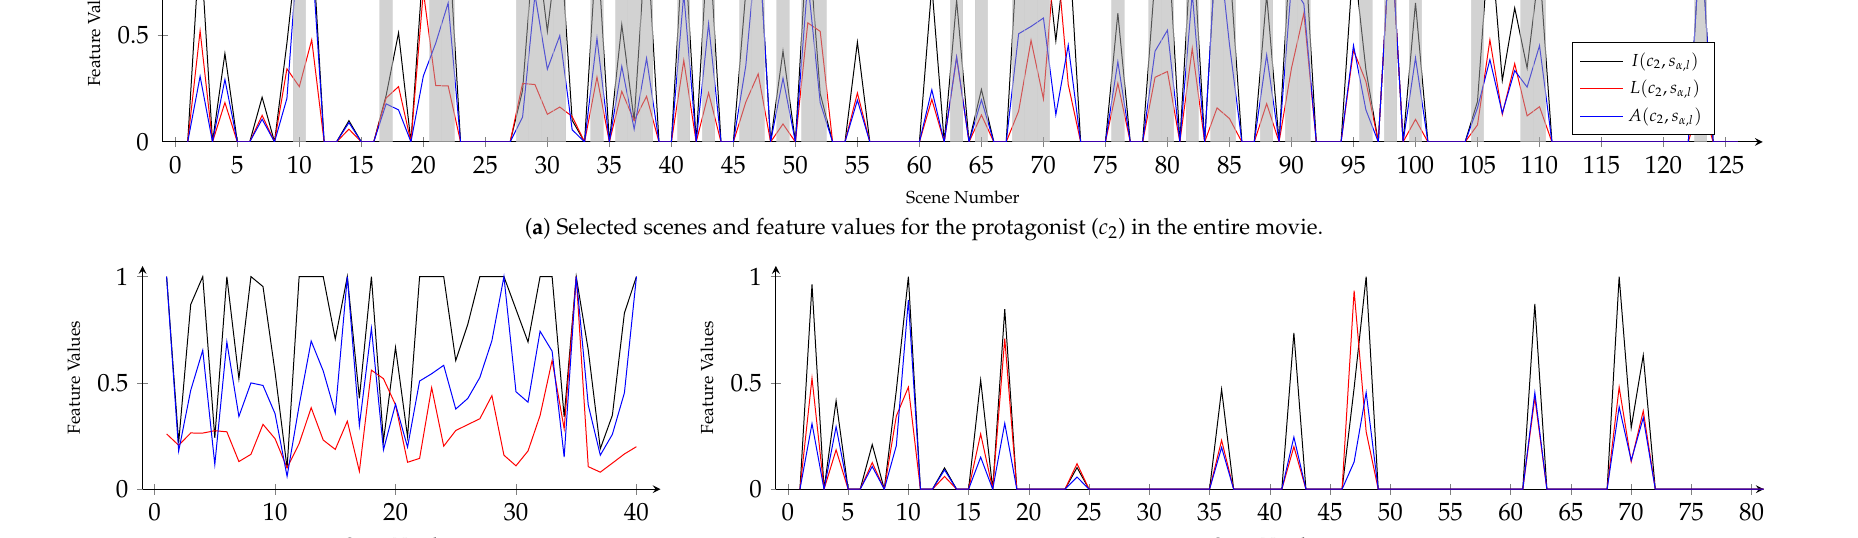
( b ) Feature values for the protagonist ( c 2 ) in the selected scenes. ( c ) Feature values for the protagonist ( c 2 ) in the remaining scenes.